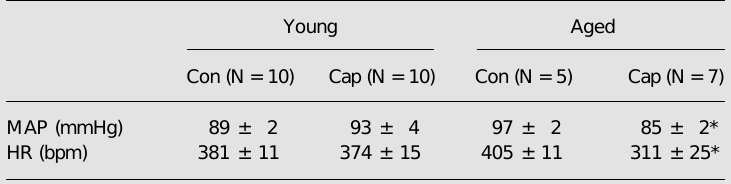
Table 1. Baseline values (mean ± SEM) of mean arterial pressure (MAP) and heart rate (HR) in conscious male young and aged rats treated (Cap) or not (control, Con) with